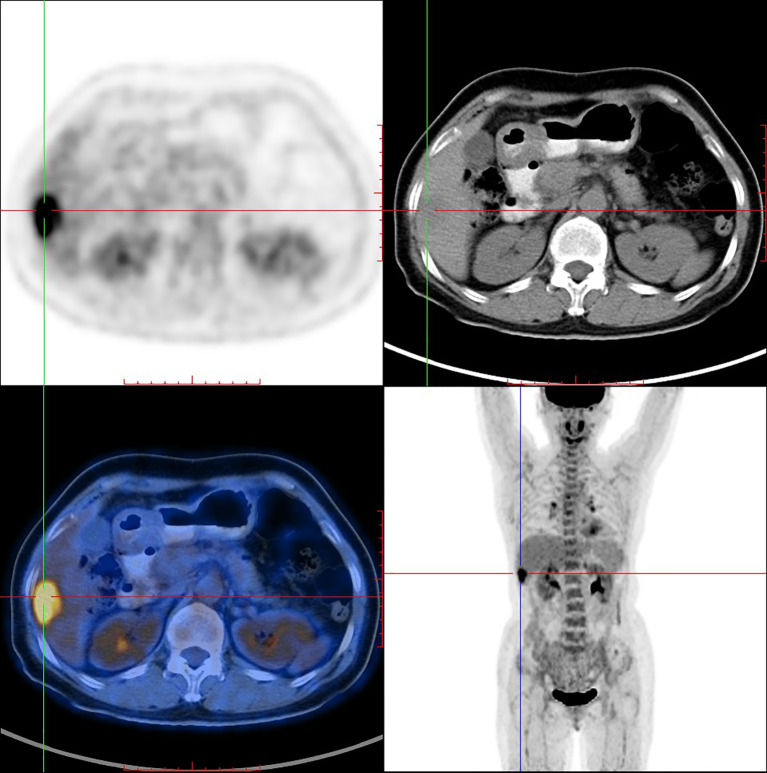

18F-FDG PET/CT imaging of the same female IDC patient (54 y).